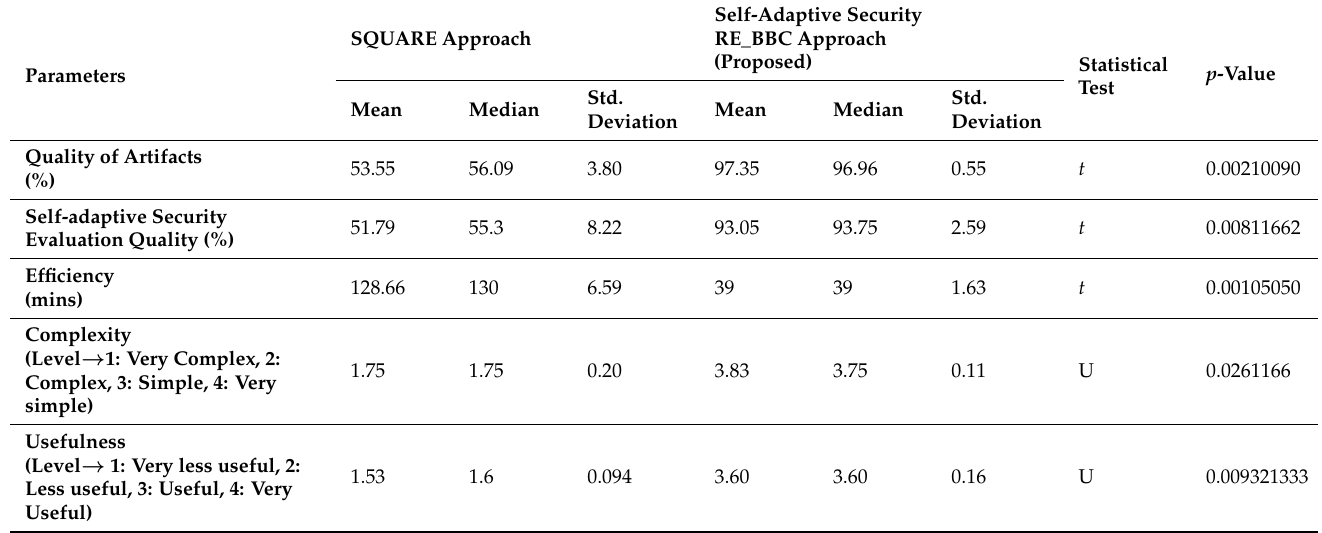
Table 5. “Statistical Test Results” based on the replicated study for healthcare data management